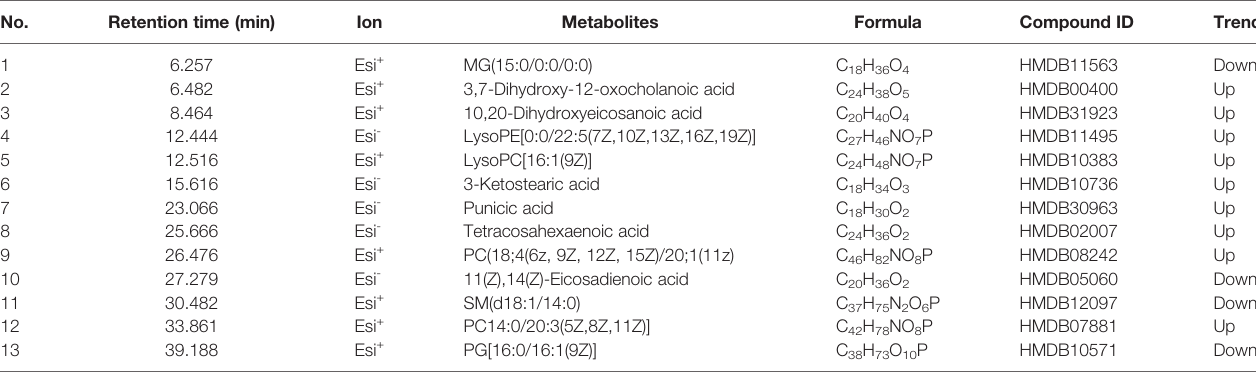
TABLE 1 | Identi fi cation of representative differential metabolites among different groups. No. Retention time (min)